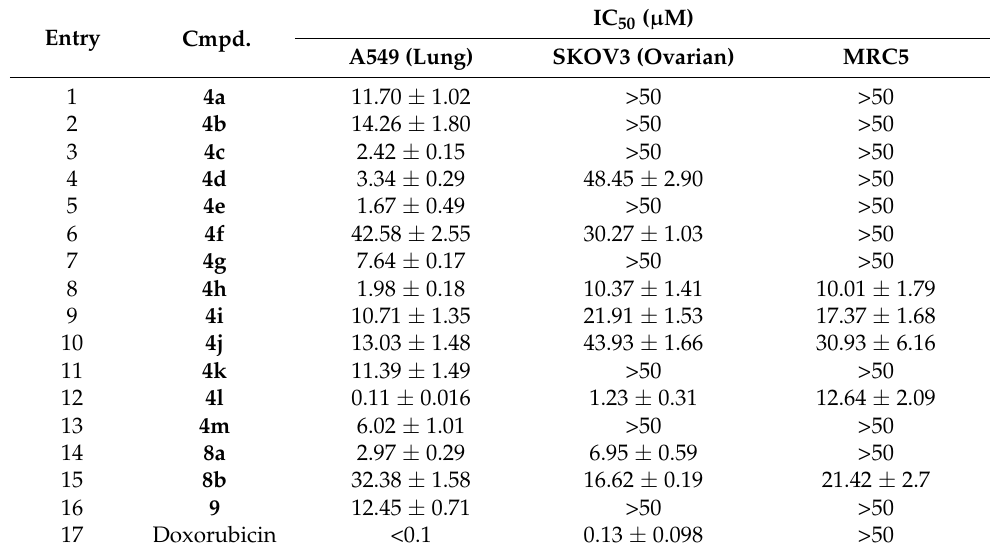
Table 1. Antiproliferative activity of 3-amino γ -lactam derivatives 4 , 8 and 9 . Entry